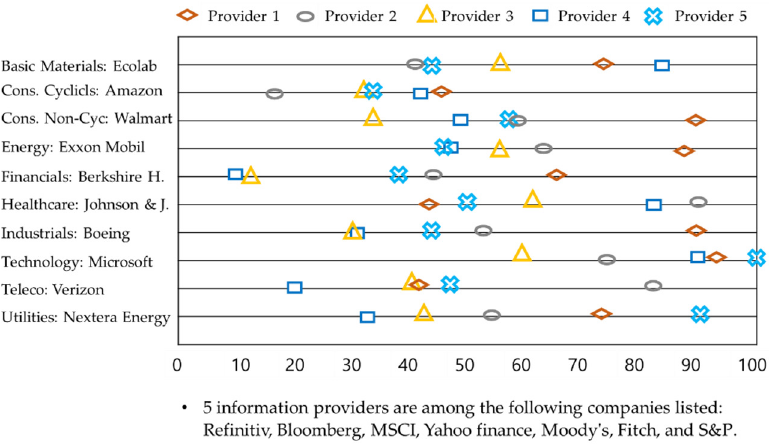
Figure 1. ESG ratings of companies from diverse industries from five information Figure 1. ESG r atings of companies from diverse industries from five information providers.